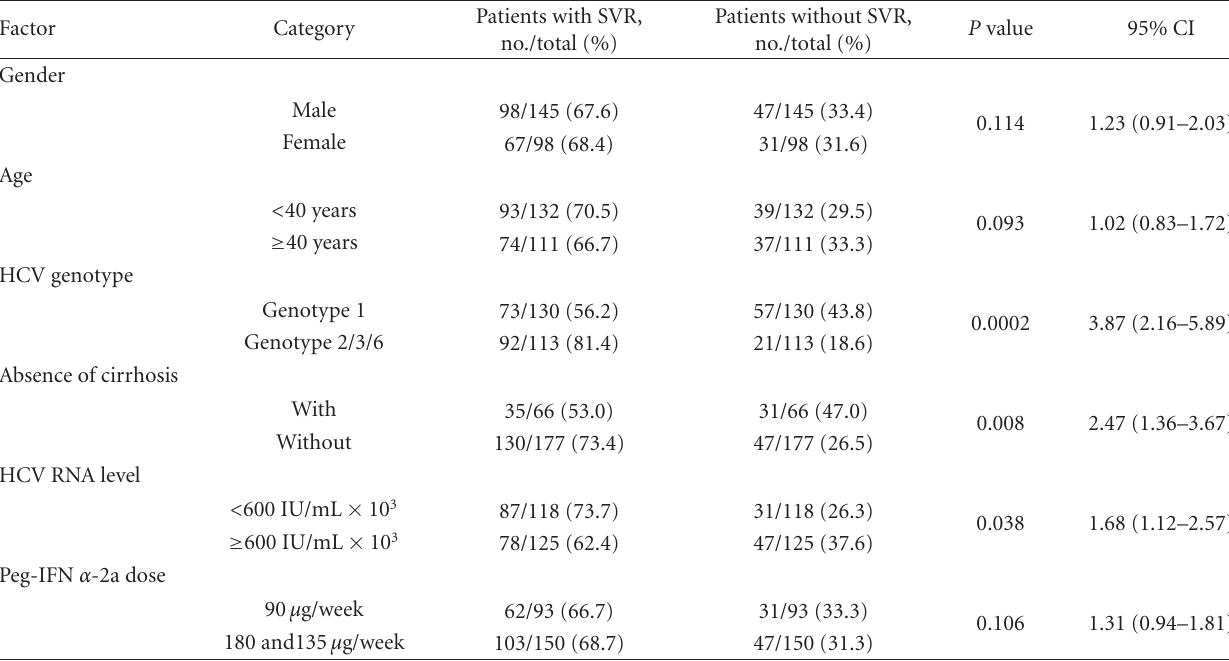
Table 3: Results of multivariate stepwise analysis for associated factor to